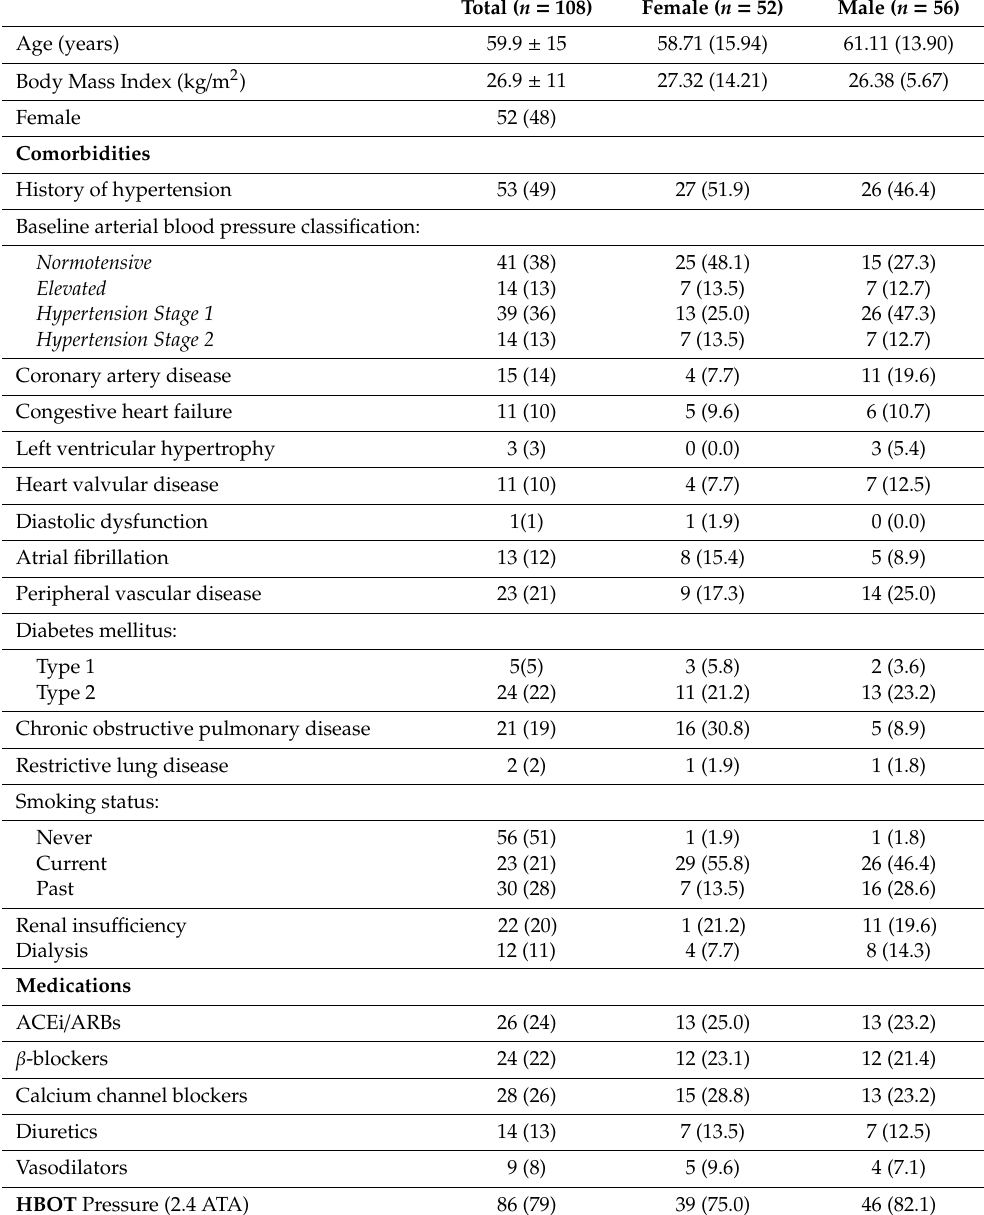
Table 1. Baseline demographics, comorbidities, and medications of the total cohort of 108 patients. Total ( n =